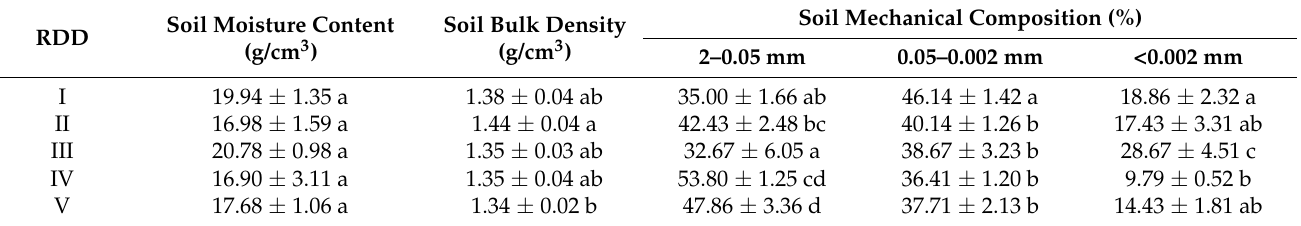
Table 3. A comparison of the soil physical properties in areas with different rocky desertification degrees in northern Guangdong.